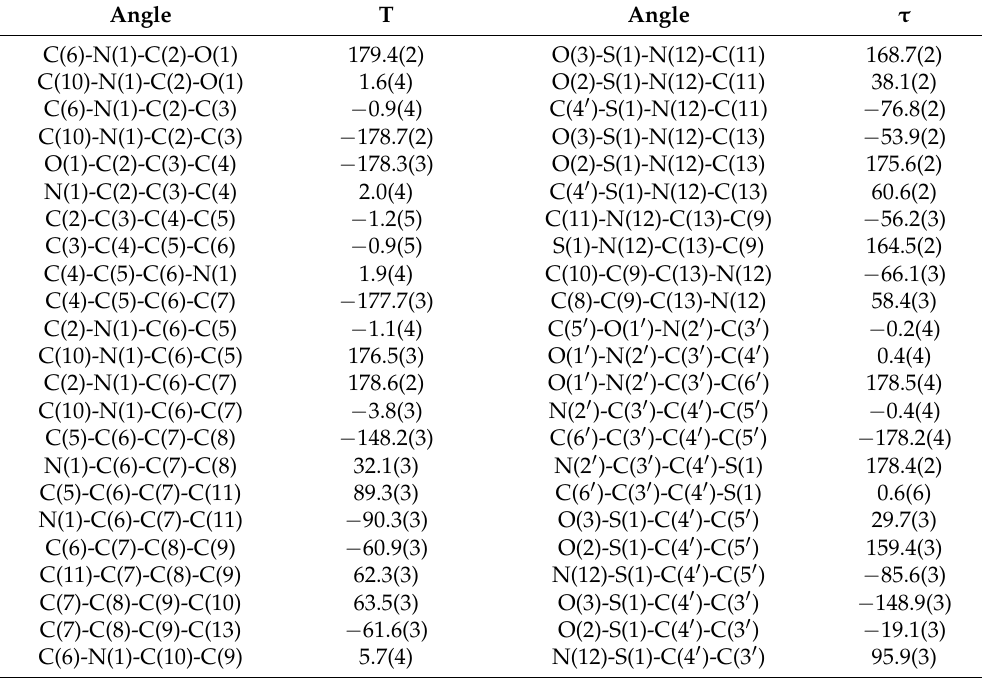
Table 3. Torsion angles ( τ , deg.) in molecule 2